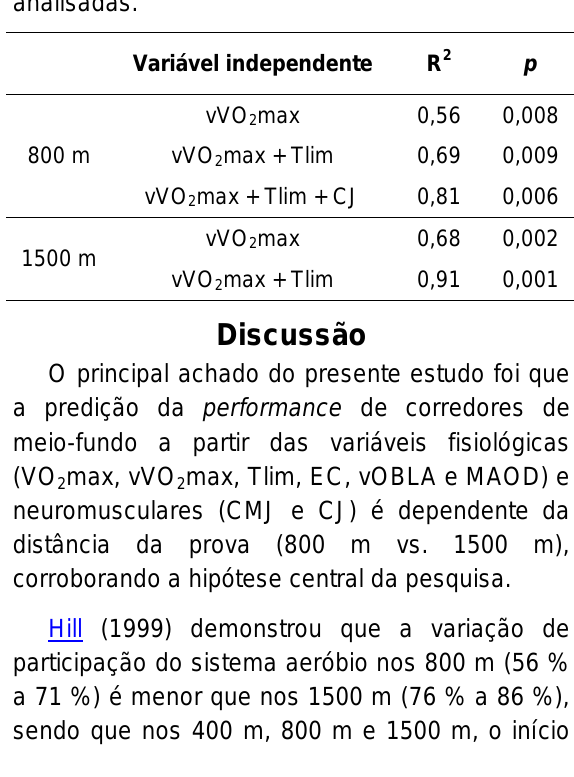
Tabela 4. Valores de coeficiente de determinação (R2) dos índices fisiológicos e neuromusculares para os tempos de provas nas distâncias